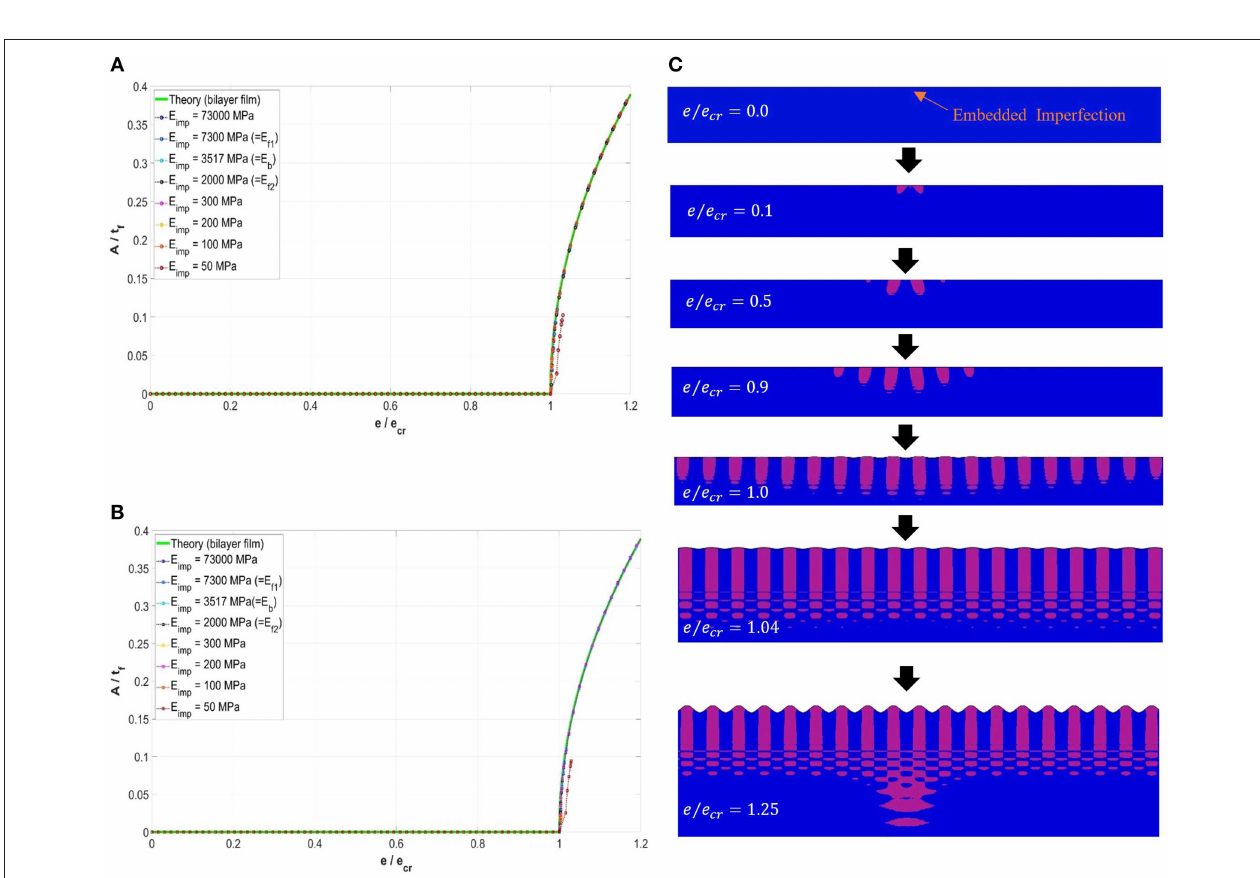
FIGURE 10 | (A,B) Variations of simulated wrinkling amplitude normalized by the total film thickness ( A / t f ), with the increase in directly applied compressive strain, e xx , for the composite film with a fractional volume percentage of 50% under generalized plane strain. (A) ν imp = 0.495, and (B) ν imp = 0.35. (C) Development of the surface wrinkles in the vicinity of a typical embedded imperfection, and the variation of the stress contours, σ yy , near the imperfection. Note that the pink color shows the tensile regions and the blue color shows the compressive and zero stress regions. Note that all the images are magnified to various deformation scales for better visualization.